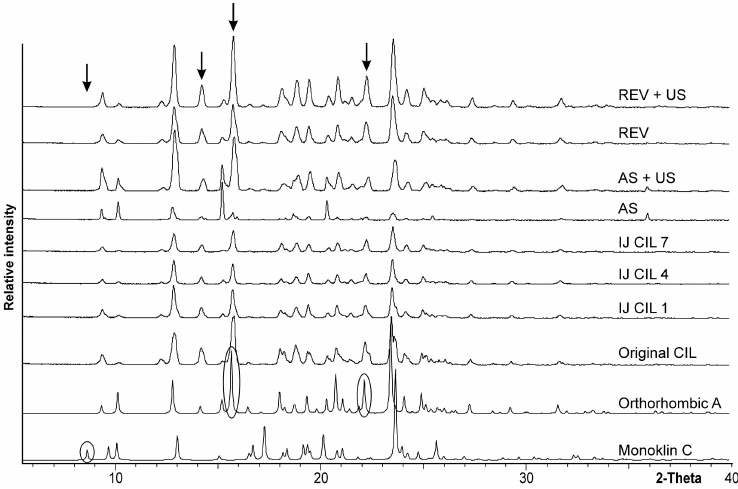
Figure 6. XRPD di ff ractograms of the crystallized